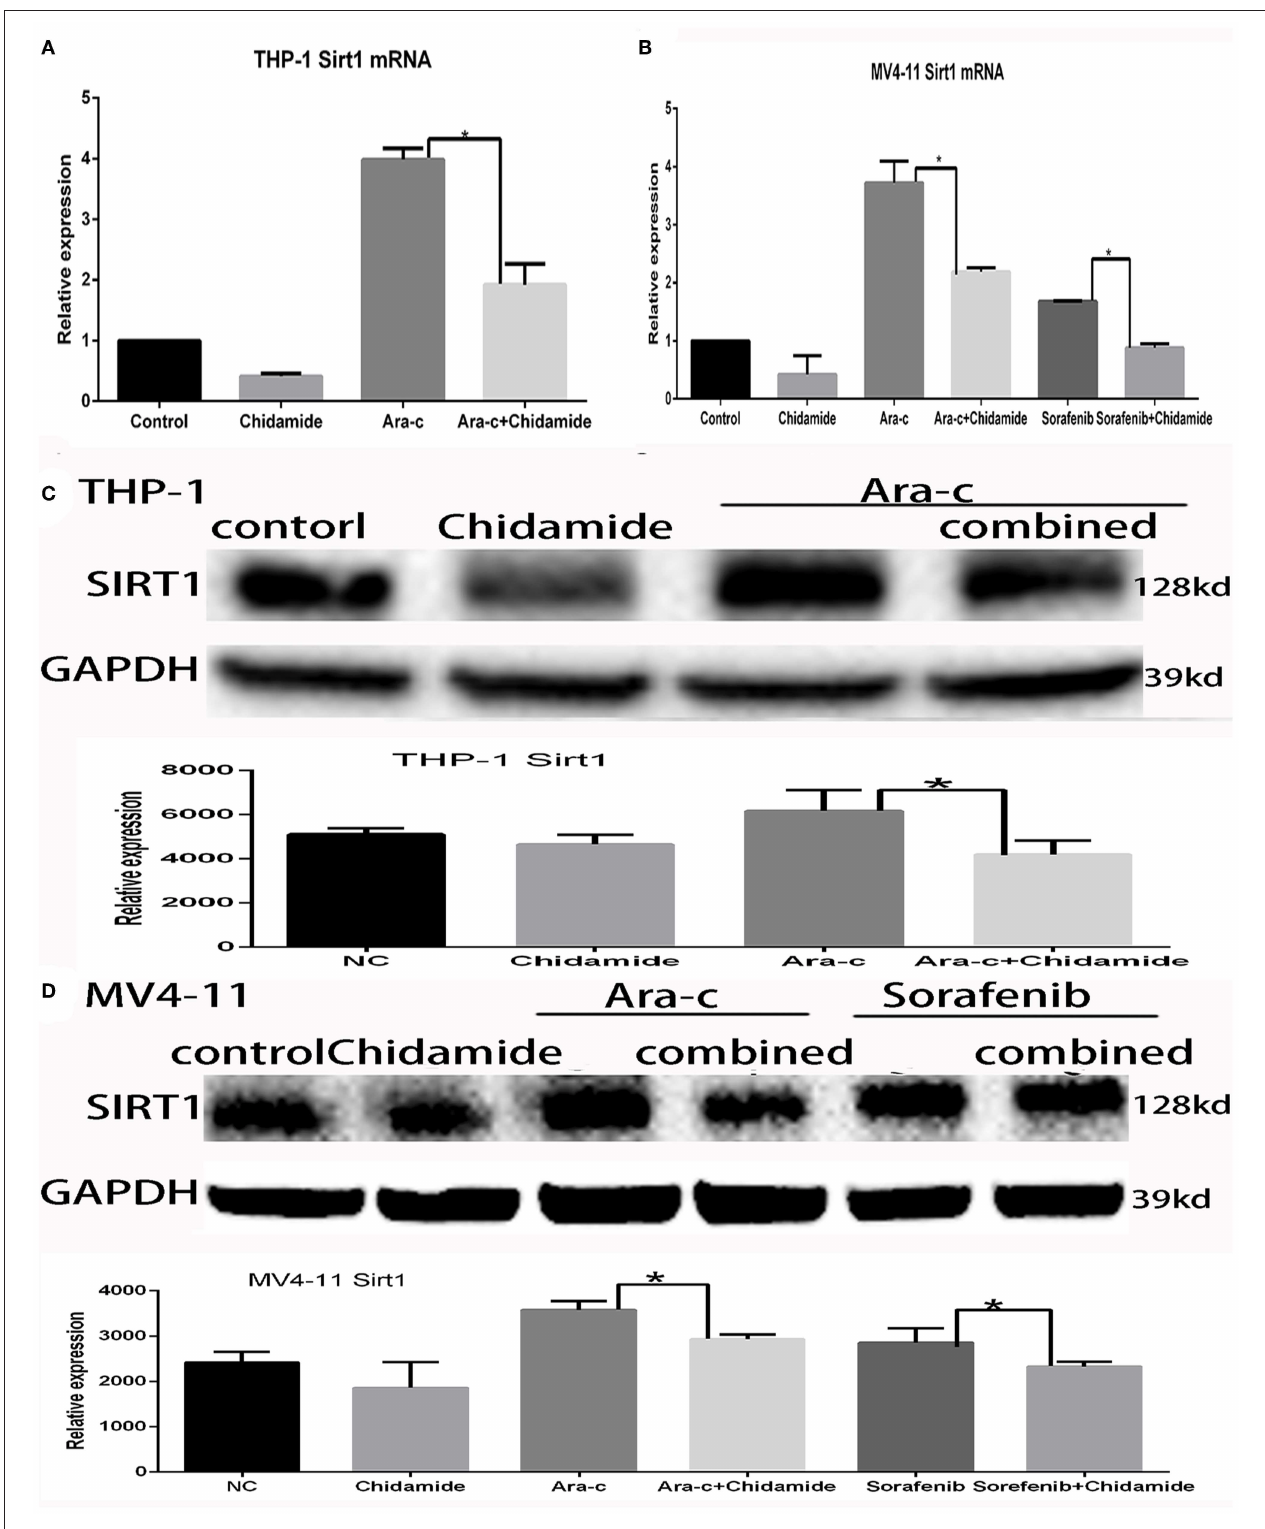
FIGURE 5 | Effect of chidamide on SIRT1 expression in acute myeloid leukemia cells. (A) RT-PCR analysis of SIRT1 mRNA levels in THP-1 cells treated with Ara-c alone or in combination with chidamide, and the SIRT1 mRNA levels decreased in THP-1 cells treated in combination with chidamide team compared with THP-1